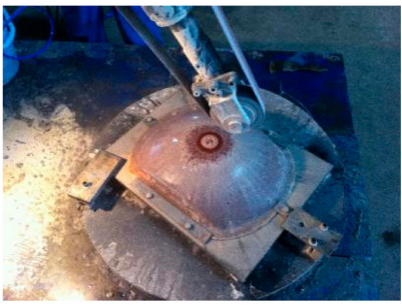
Figure 13. Radome in